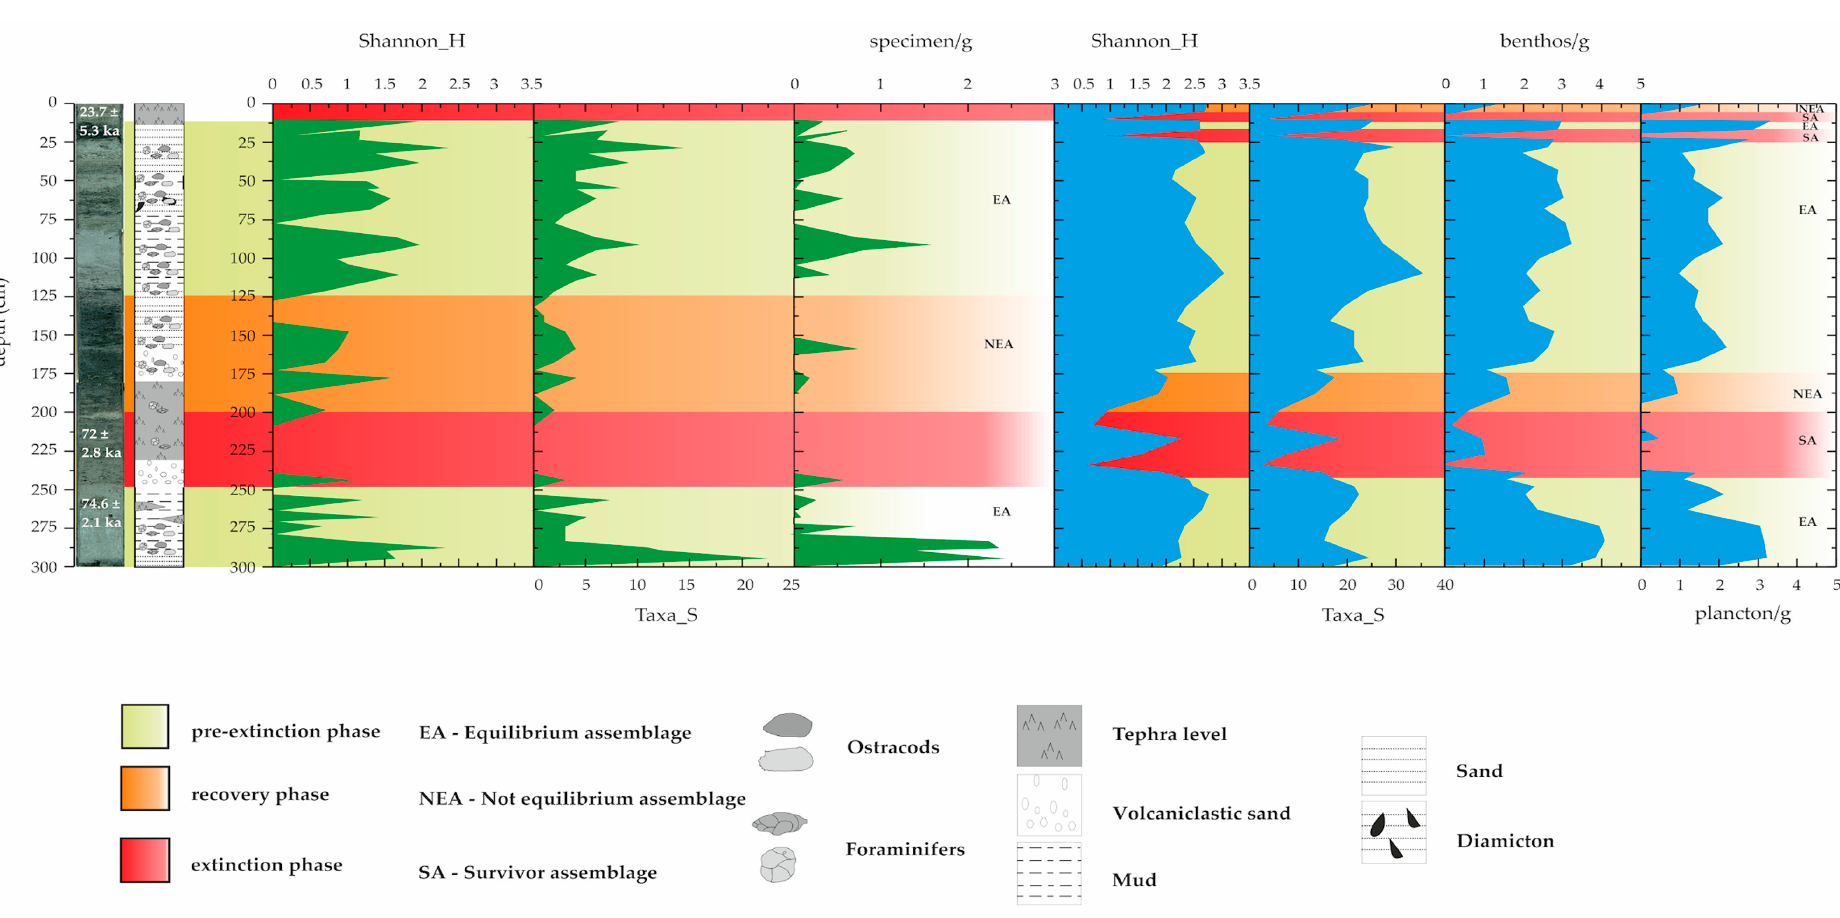
Figure 2. From left to right: down-core of distribution ostracods (in green) and foraminifers (in blue) in terms of Shannon diversity index (Shannon_H), species richness (Taxa_S), and total abundance (>63 µ m fraction) in the number of specimens per gram of dry sediment in core ANTA02-NW2. Specimen/g, plankton/g, and benthos/g values are reported in logarithmic values to simplify the reading of the data, because of the high difference in numerical terms from the bottom to the top core levels. The different ecological intervals concerning the ostracod and foraminiferal behaviour in relation to volcanic events are shown (EA = equilibrium association; SA = survivor association; NEA = non-equilibrium association). For details, see the legend in this figure.